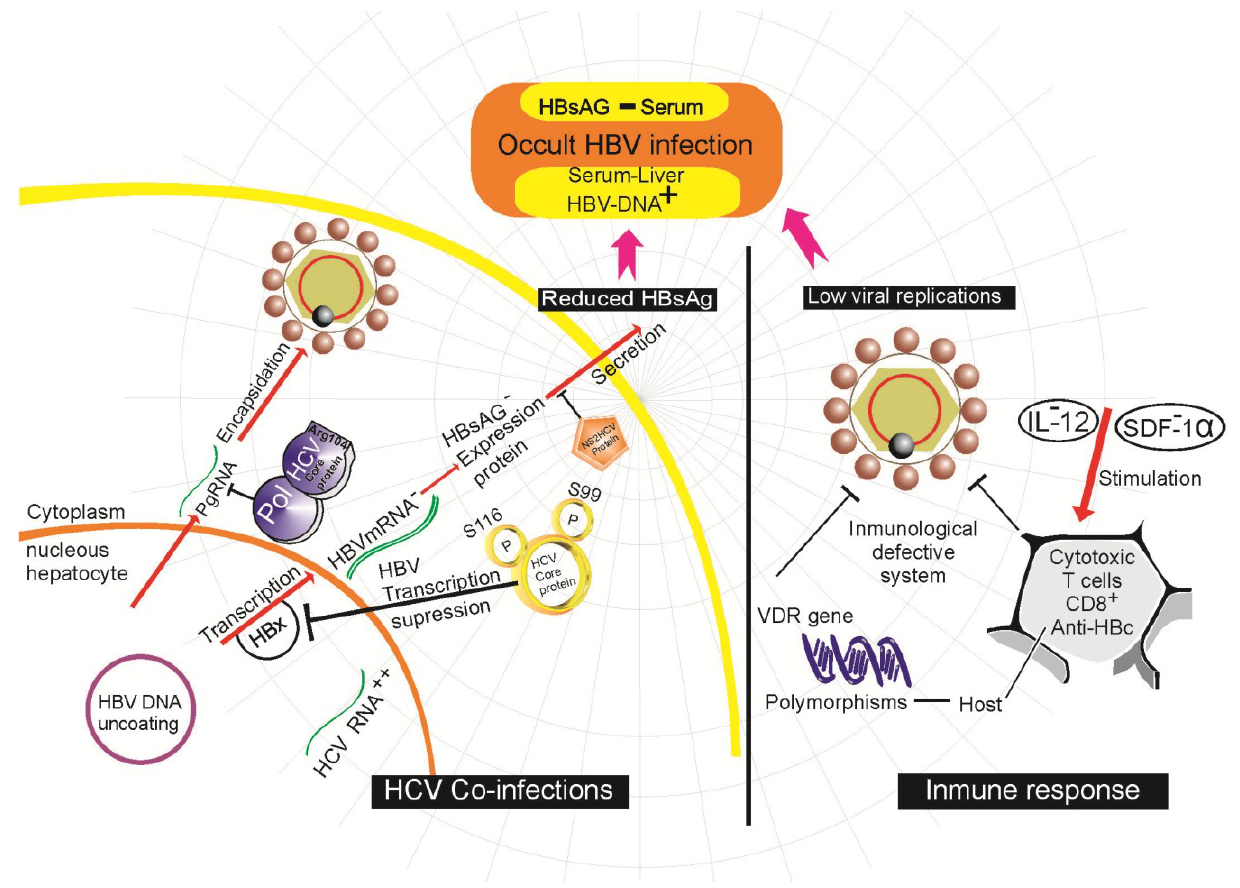
Figure 2. Molecular mechanisms described in occult hepatitis B virus infection (OBI)